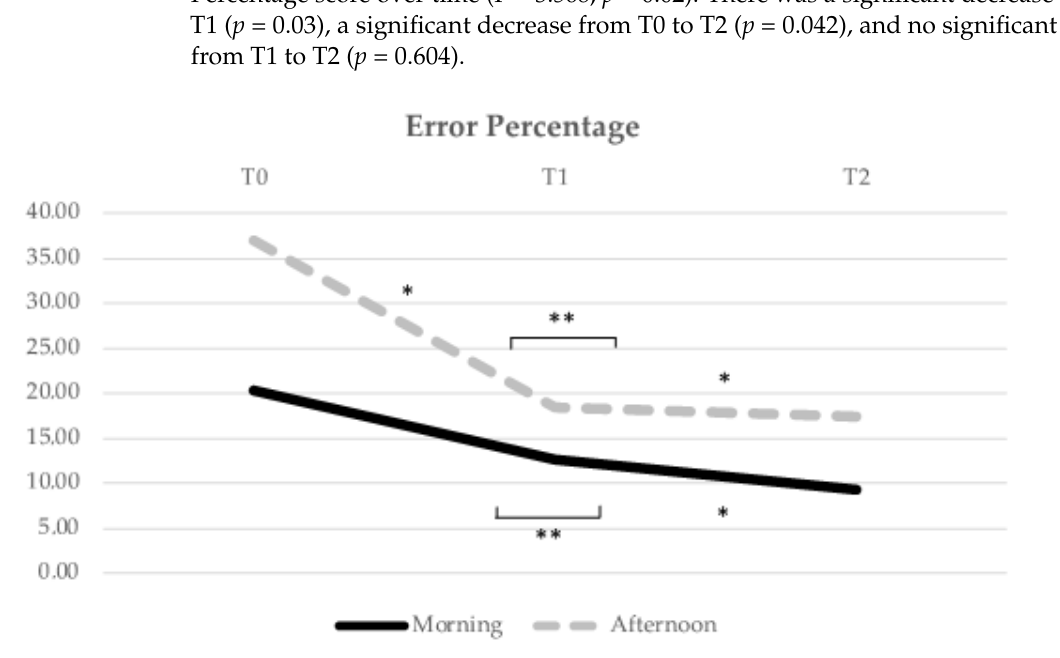
Figure 4. Evolution of the Error Percentage mean score over time (from T0 to T1, i.e., from pre- to post-acute exercise; and from T1 to T2, i.e., from post-acute exercise to post-chronic exercise). * Indicates significant differences for p < 0.05; ** Indicates significant differences for p < 0.01.